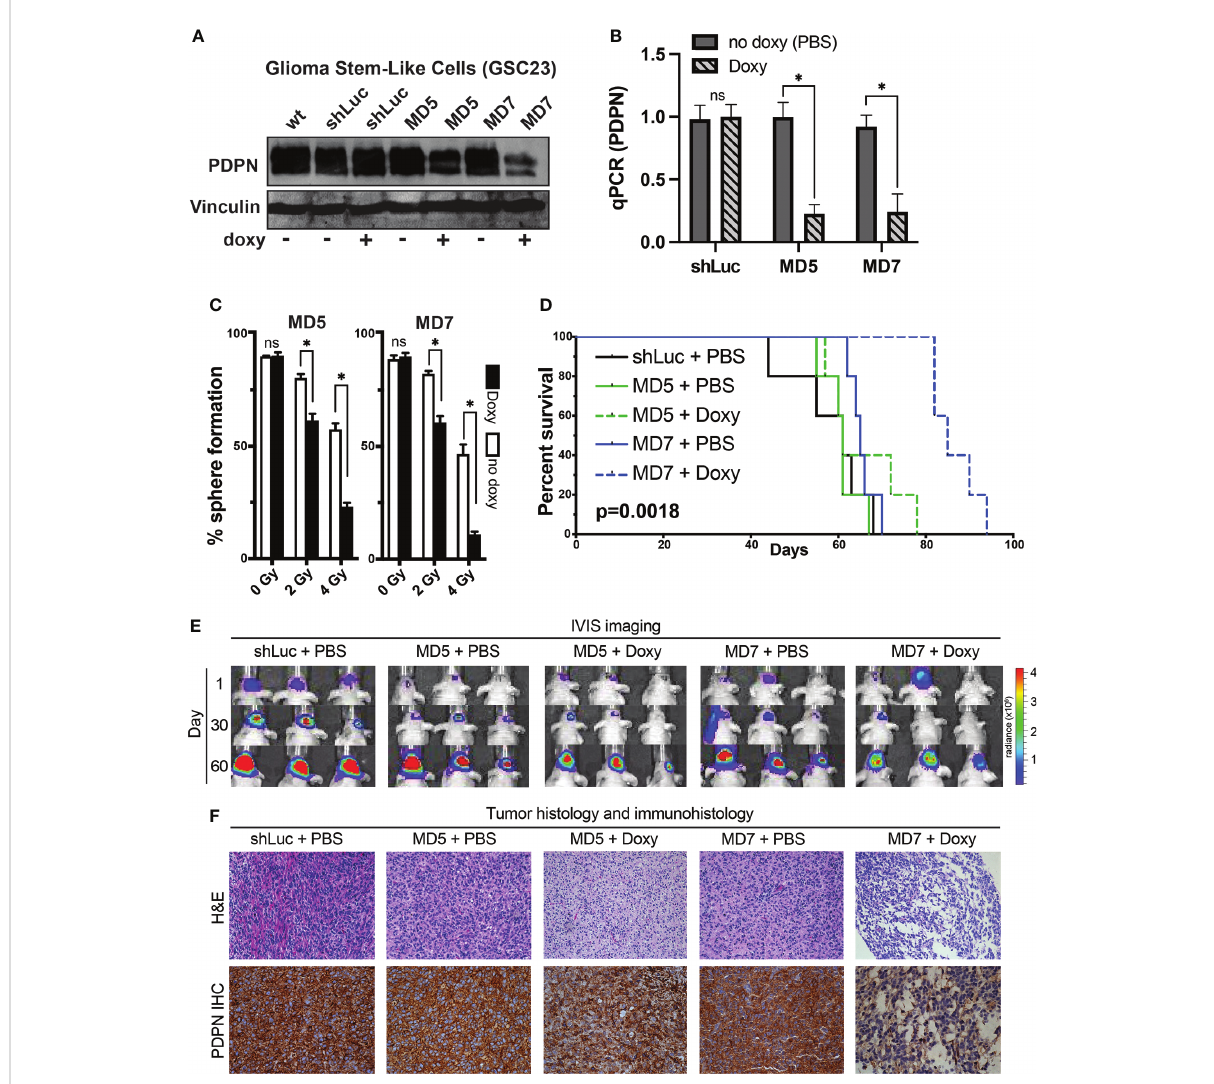
FIGURE 4 PDPN knockdown in glioma stem-like cells leads to radiosensitization in vitro and slows intracranial tumor growth. (A) Western blot of GSC line 23 (GSC23) showing PDPN expression levels after exposure to doxycycline (doxy), indicating inducible PDPN knockdown. (B) qPCR validation of PDPN knockdown (*p<0.005, two-tailed t-test). (C) In vitro clonogenic survival assays revealed that PDPN silencing by the shRNA MD5 and MD7 was effective in sensitizing GSC23 spheres to radiation in a dose-dependent manner [0 Gy, not signi fi cant (ns); 2 Gy, *p<0.0001; 4 Gy, *p<0.0001]. (D) Kaplan – Meier survival analysis (n=5 per condition) of PDPN knockdown, with negative (shLuc and no doxy) controls (p=0.0018, log-rank test). (E) Time course IVIS imaging of tumors from days 1, 30 and 60. (F) Representative tumor histology and PDPN IHC of animal tumors at time of animal